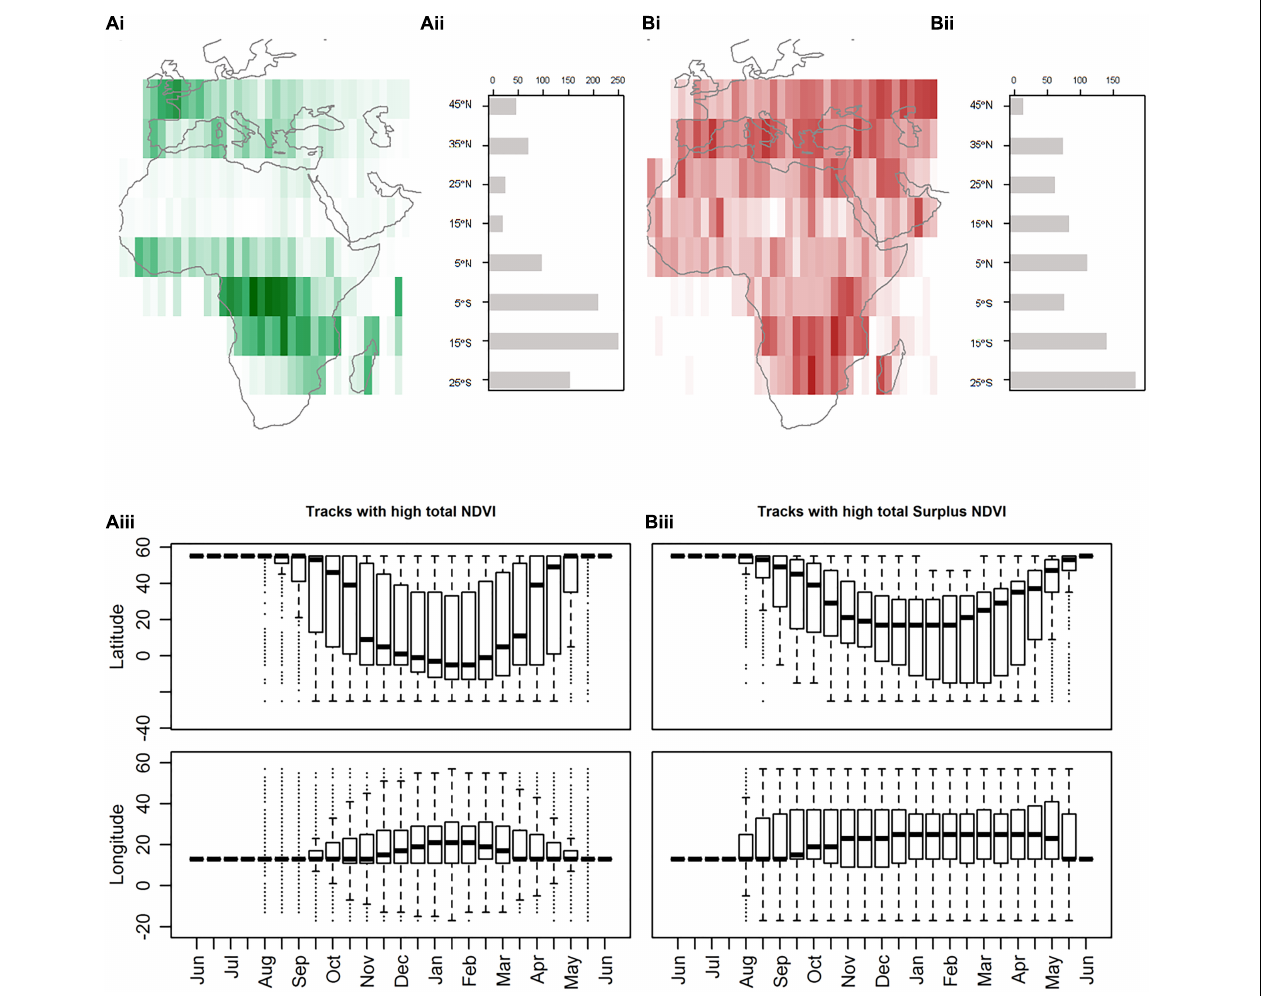
FIGURE 3 | Space use of highest NDVI and Surplus NDVI tracks across the annual cycle. (A) Tracks with high total NDVI of all those generated ( n = 740) and (B) total Surplus NDVI ( n = 640). Count of cell use for high performance tracks aggregated every 10 ◦ of latitude south of the breeding site (i) . Breeding sites are excluded from counts. Histogram (ii) of count of the southern extent of the same high performance tracks (from 45 ◦ N to 25 ◦ S). Latitudinal and longitudinal profiles (iii) for each temporal period. The boxplots represent the median value and upper and lower quartiles. Whiskers represent the 95% confidence interval and outliers are shown by